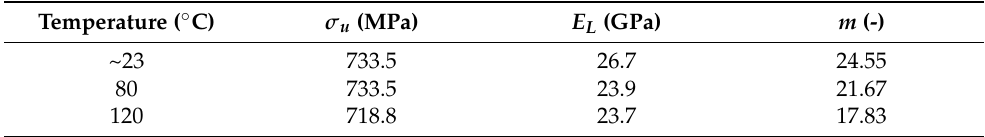
Table 1. Static tensile properties of BFPP rods.